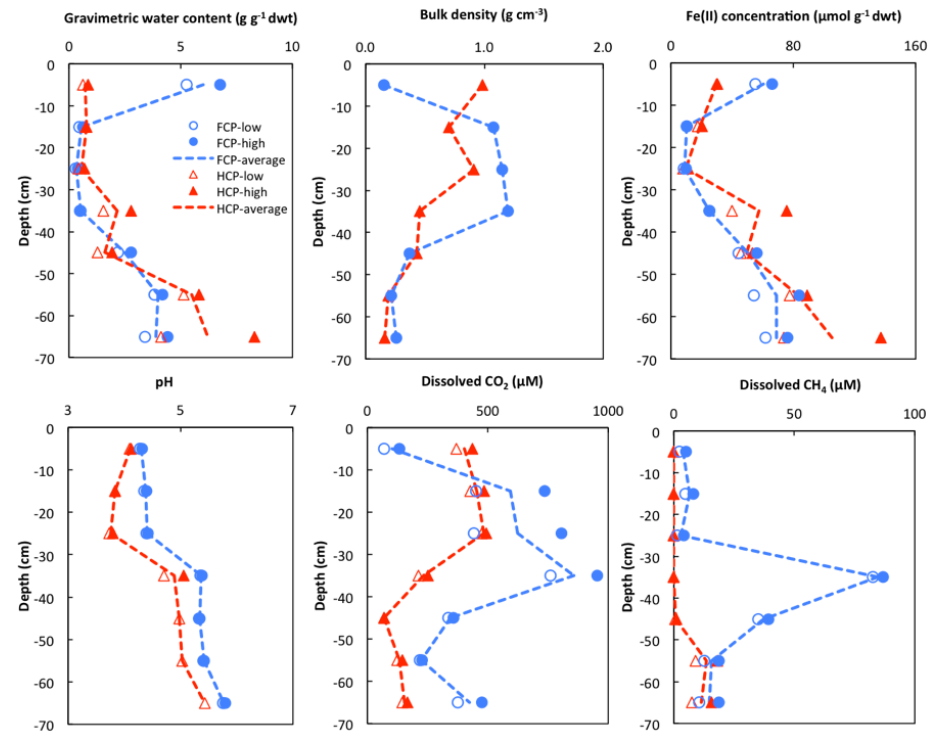
Figure 2. Depth profile of gravimetric water content, bulk density, Fe(II) concentration, pH, and soil pore water dissolved CO 2 and CH 4 concentrations from FCP (blue) and HCP (red) cores. Replicate measurements were plotted as high and low values in each soil section as blue filled and empty circles (FCP) and red triangles (HCP). Trend lines were plotted based on the average values.